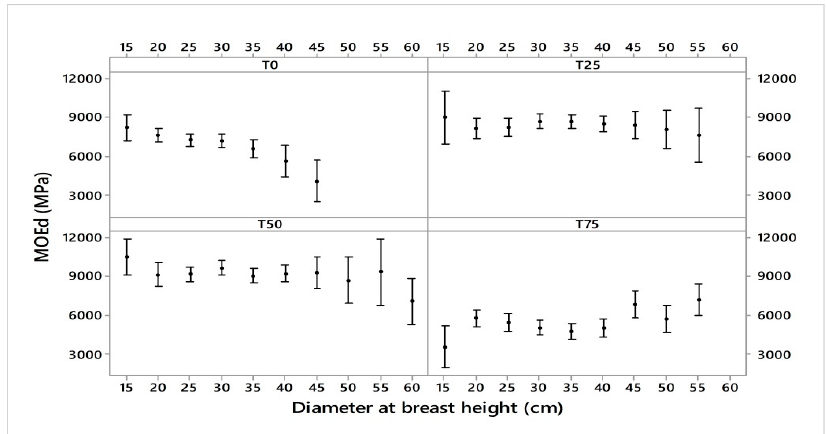
Figure 5. Dynamic modulus of elasticity (MOEd) in relation to the diameter classes for each intensity of thinning. For Control, F 6;191 = 3.371; p = 0.006; for T25, F 8;189 = 0.658; p = 0.728; for T50, F 9;188 = 1.600; p = 0.118; for T75, F 8;189 = 2.330; p = 0.021.